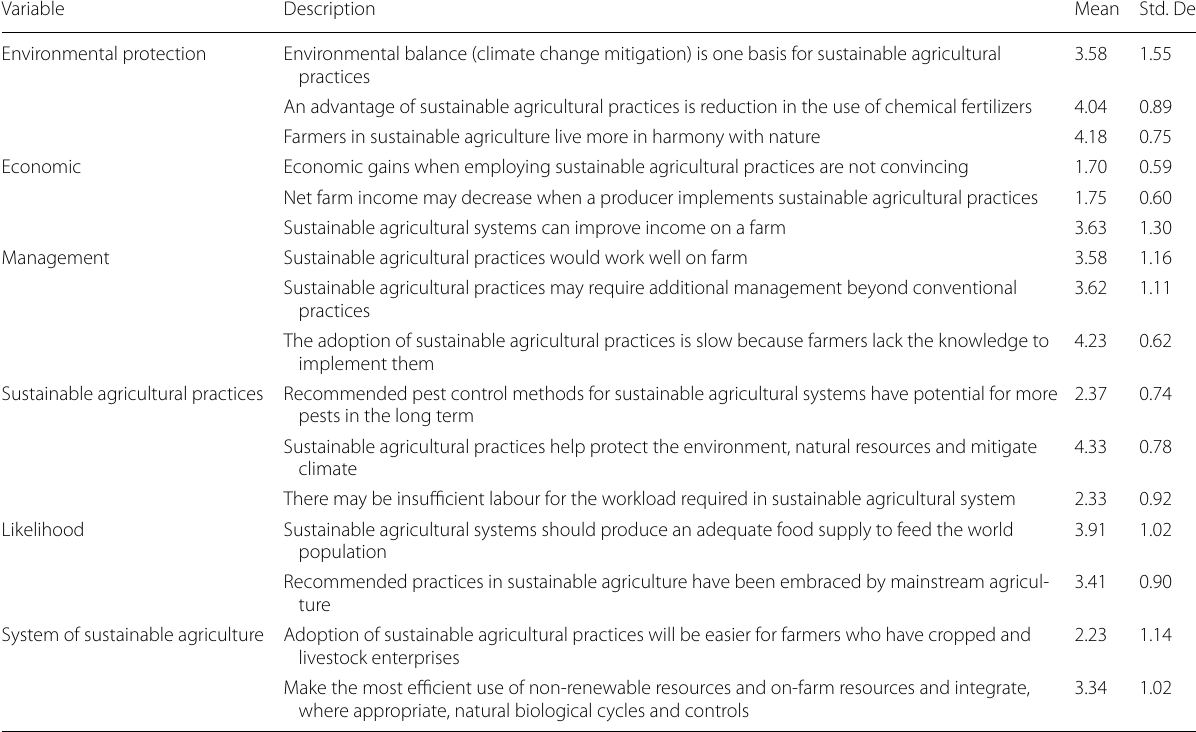
Source: Field survey (2018)